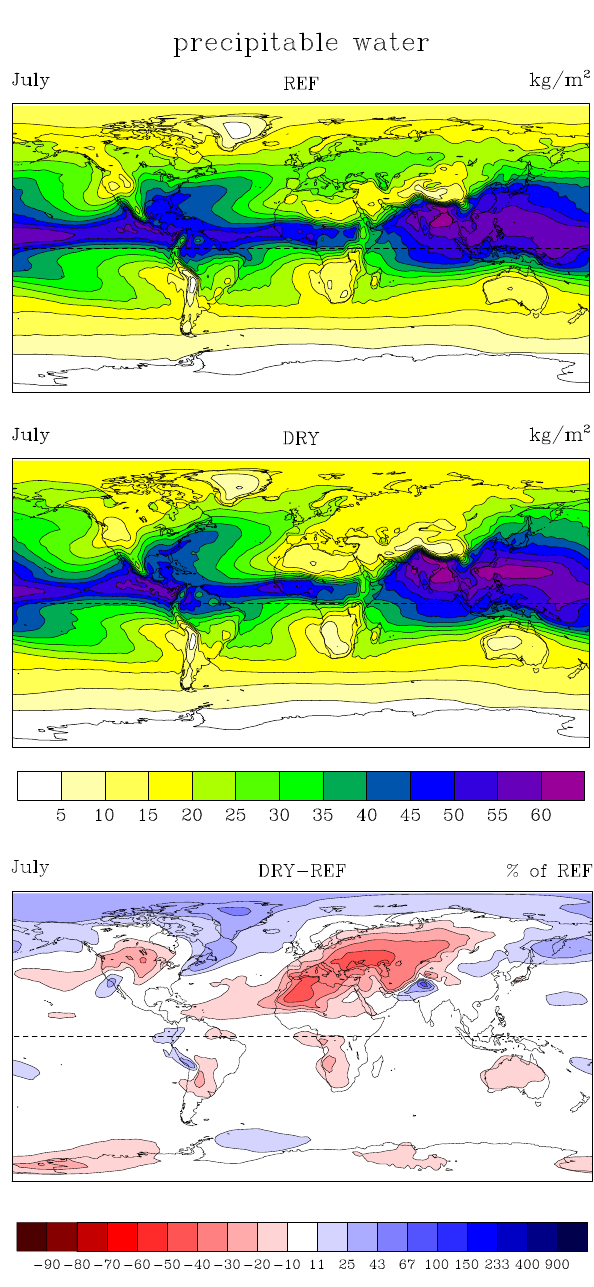
Fig. 5. Precipitable water (kgm − 2 , vapour+liquid+ice) in July in the REF experiment (top panel), in the DRY experiment (middle panel), and the difference between the two (bottom panel, %). Note that the colour scale of the difference plot is kept identical to the ones used in Figs. 2 and 4, bottom, to allow for direct comparison. The values of the blue part of the colour scale of the difference plot equate to (10%, 20%, ..., 90%) in relation to the DRY experiment. See Fig. S4 in the Supplement for